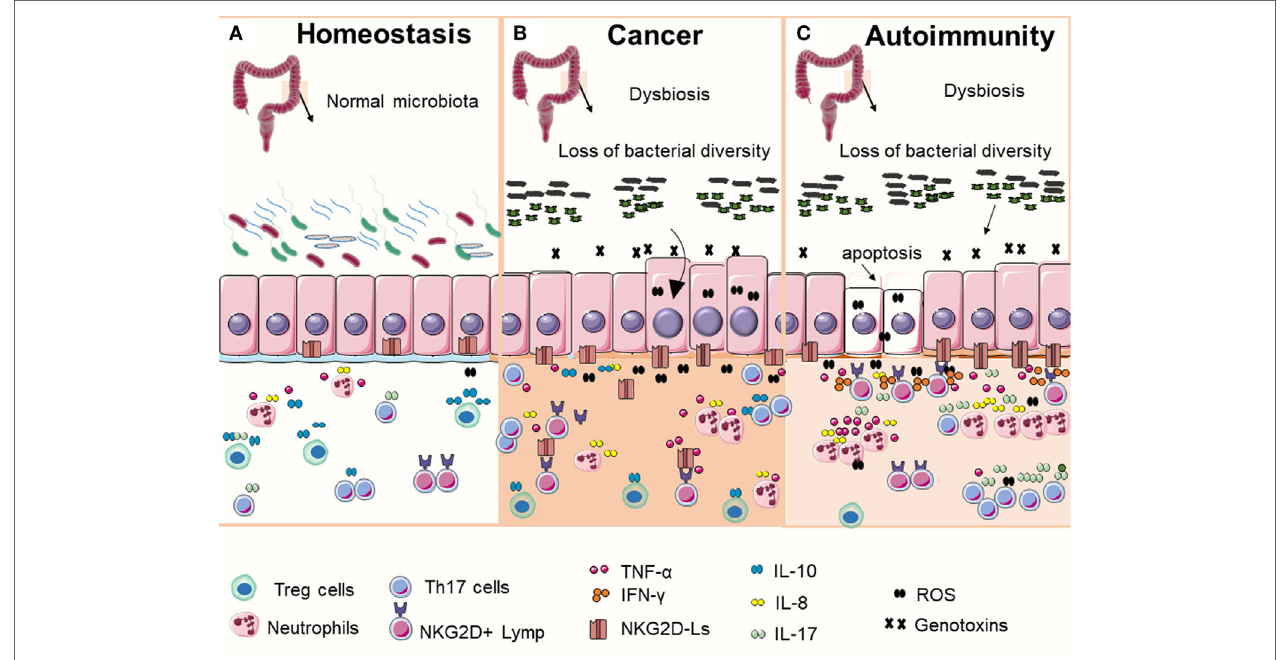
FiGURe 1 | Commensal bacteria play an important role in maintaining gut homeostasis (A) . In normal condition, intestinal epithelial cells express low levels of NKG2D ligands (NKG2D-Ls) (mostly intracellular) and beneficial bacterial contribute to immune education and help to maintain immune tolerance by promoting the induction and accumulation of regulatory T cells (Treg cells). In the context of microbial imbalance (dysbiosis), pathogenic bacteria may release genotoxins that generate DNA damage in host cells. DNA damage response (DDR) is then activated, which may lead to cell cycle arrest, apoptosis, or NKG2D-Ls induction in exposed cells. These events, together with the sustained immune activation in response to dysbiosis may eventually contribute to the development of autoimmune disorders or malignant transformation. Although the precise mechanisms that determine why cells take one of these two contrasting cell fates are unclear, current data appear to suggest that (B) bacteria-induced DNA damage in cells with failed DDR (caused by mutations or by inhibitory factors secreted by bacteria) may result in the survival and proliferation of cells with unrepaired DNA, increasing the risk of malignant transformation. Transformed cells may release or shade NKG2D-Ls that impairs NKG2D receptor-mediated functions leading to failed immune surveillance and tumor growth. (C) Alternatively, the chronic exposure to genotoxin-secreting bacterial in host cells with fully functional DDR may result in NKG2D-Ls overexpression via ataxia telangiectasia mutated activation leading to increased risk of